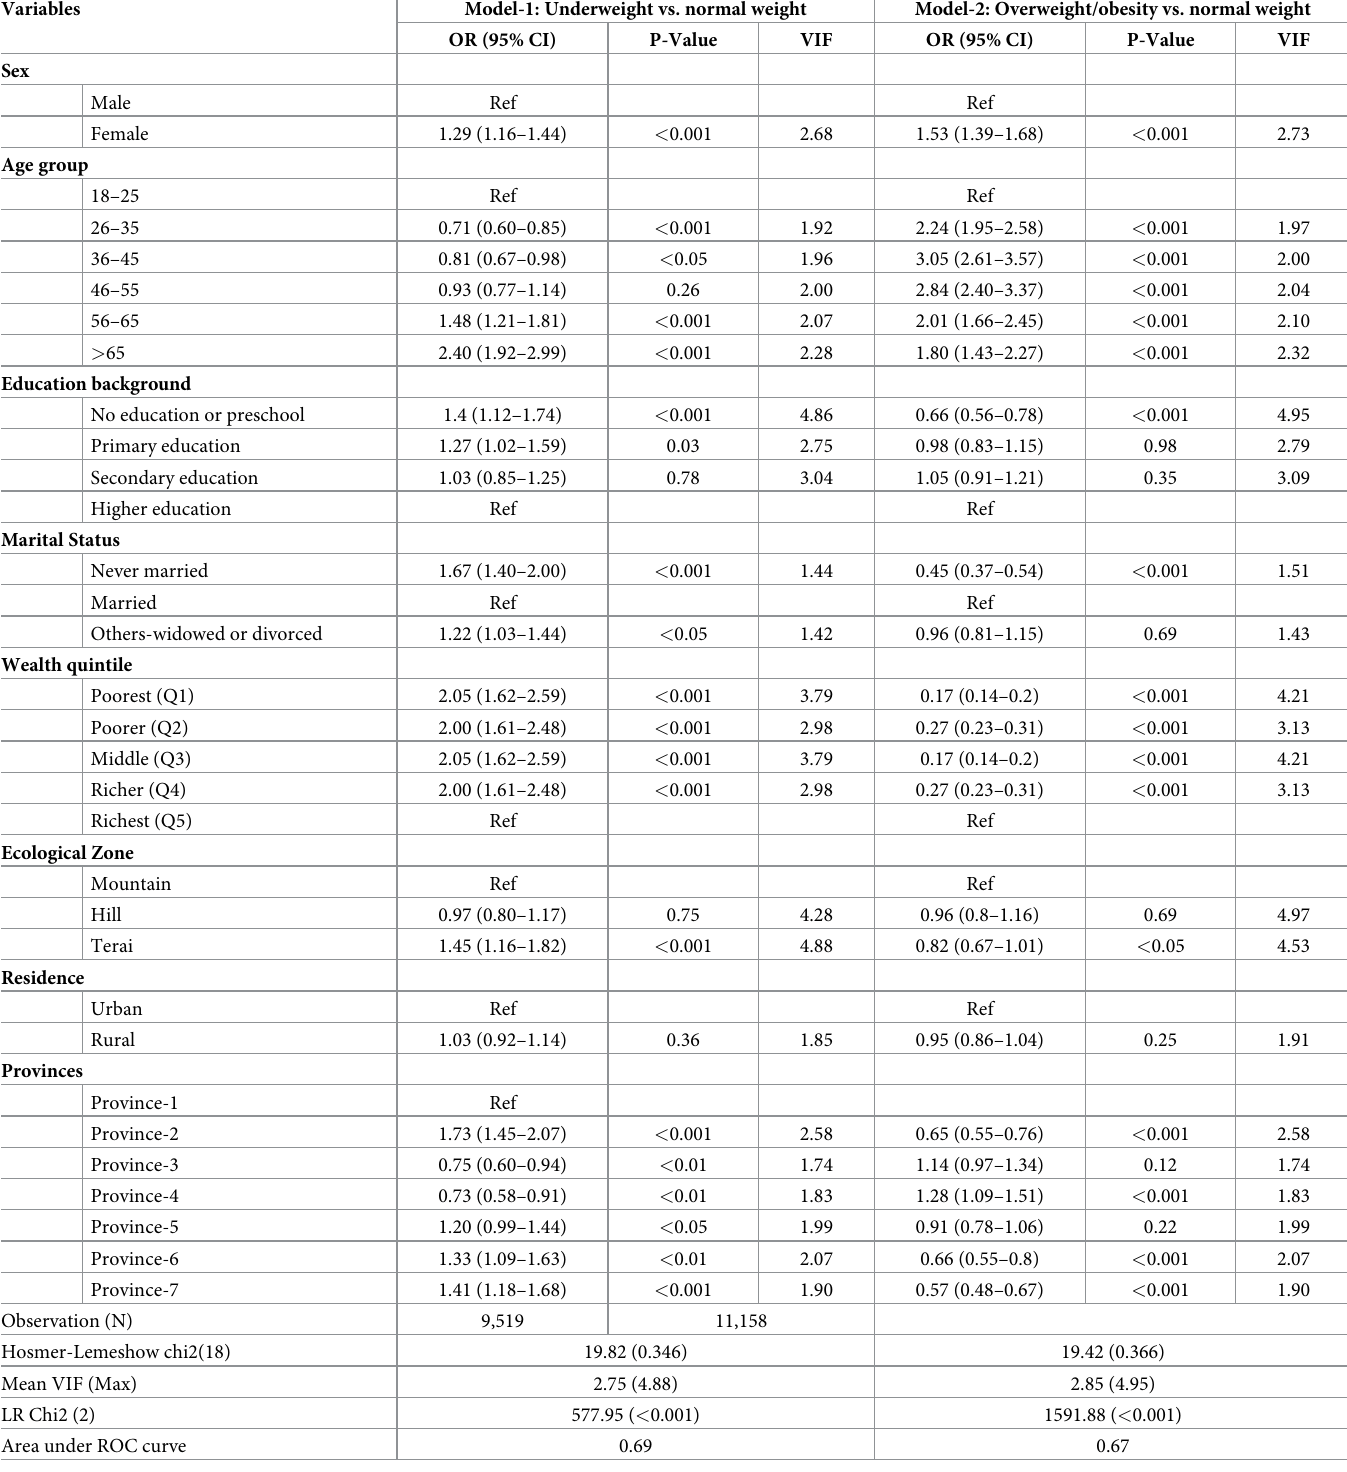
Table 3. Adjusted odds ratios for factors associated with underweight compared to normal weight and overweight/ obesity compared to normal